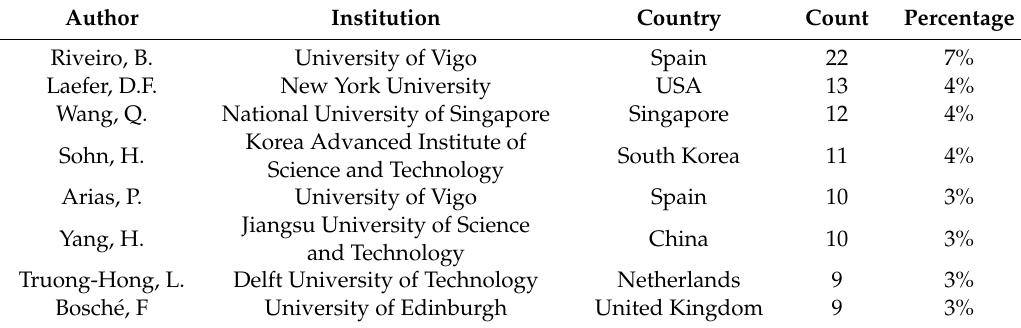
Table 4. List of the top 8 most productive authors (2010–2020).